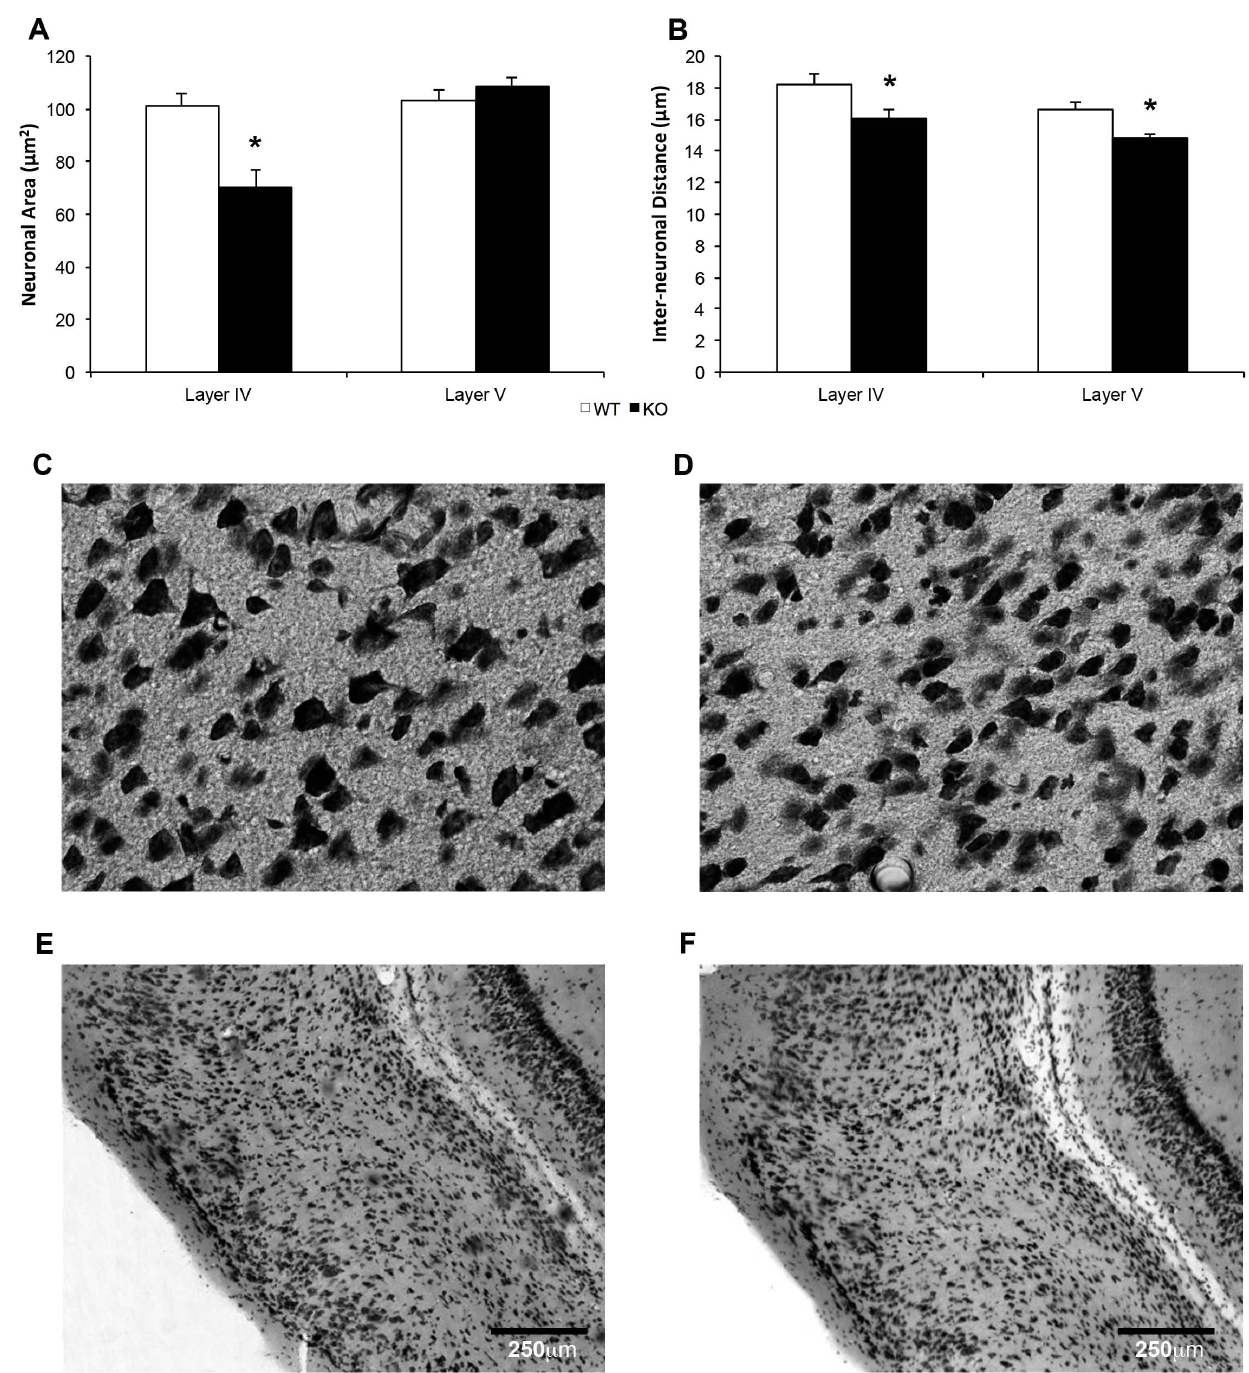
Figure 5. Entorhinal cortical cellular characteristics in PTN KOs and WTs. (a) Neuronal area and (b) interneuronal distance in layer IV and layer V of the entorhinal cortex in KOs (n=9) and WTs (n=10). Nissl-stained sections of layer IV of entorhinal cortical tissue in a (c) WT and (d) KO; and whole sections of entorhinal cortex in a (e) WT and (f) KO. Scale bar=250 mm. *p= , 0.05.